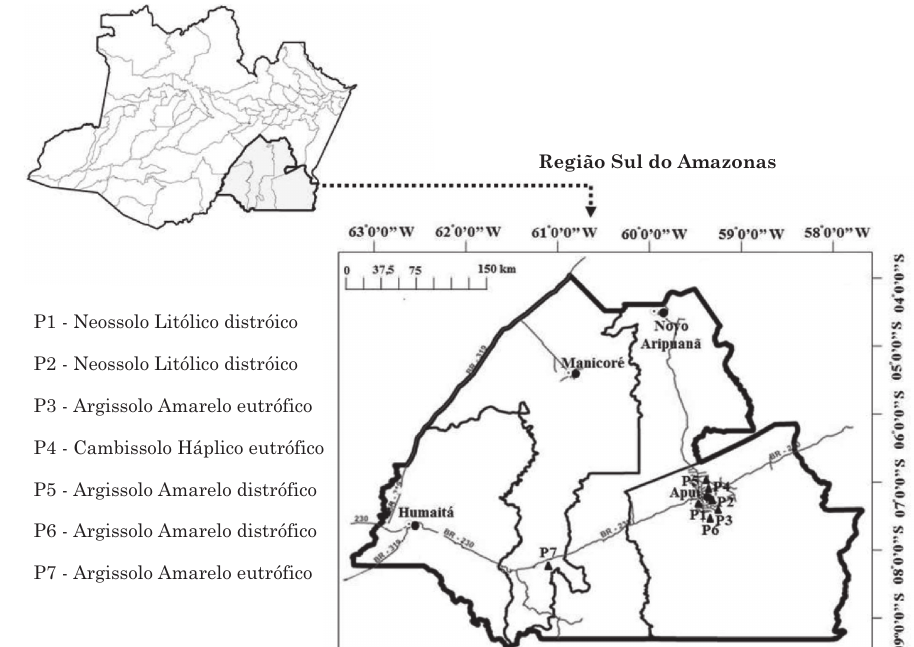
Figura 1. Localização das Terras Pretas Arqueológicas estudadas com as respectivas classificações dos